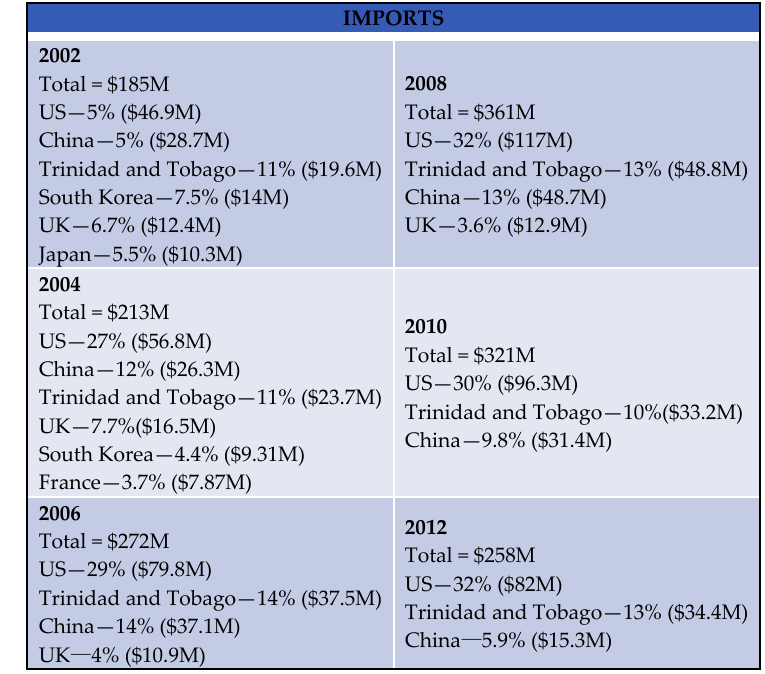
Table 3. Percent Share of Top Import Partners.